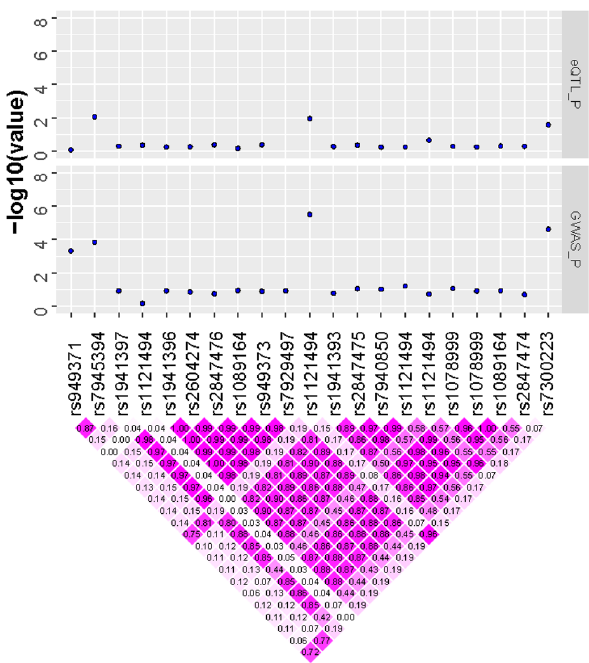
Figure 3. Integrating results of GWAS and functional